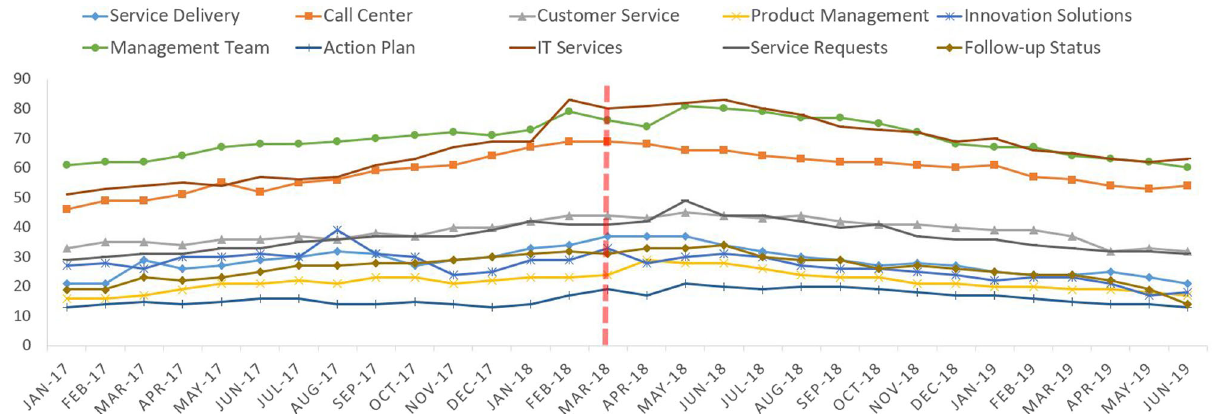
Fig. 6 The top 10 negative topics across all reviews before and after the implementation of the model. Topics have been modeled live since March 2018. The graph illustrates the number of negative topics in each category and their trends before and after the model was employed.